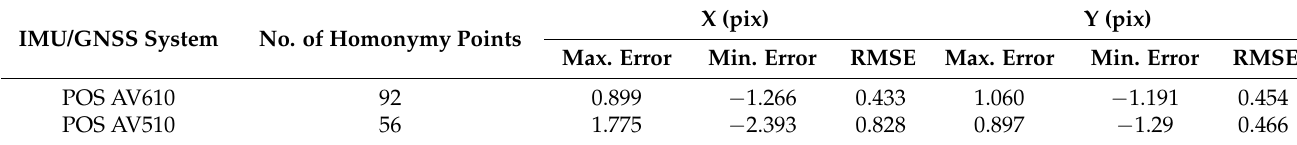
Table 10. Table 10. Stitching error of EA-stable-4 (left-middle image). Table 9. Relative orientation residual of EA-stable-4 (left-middle image)